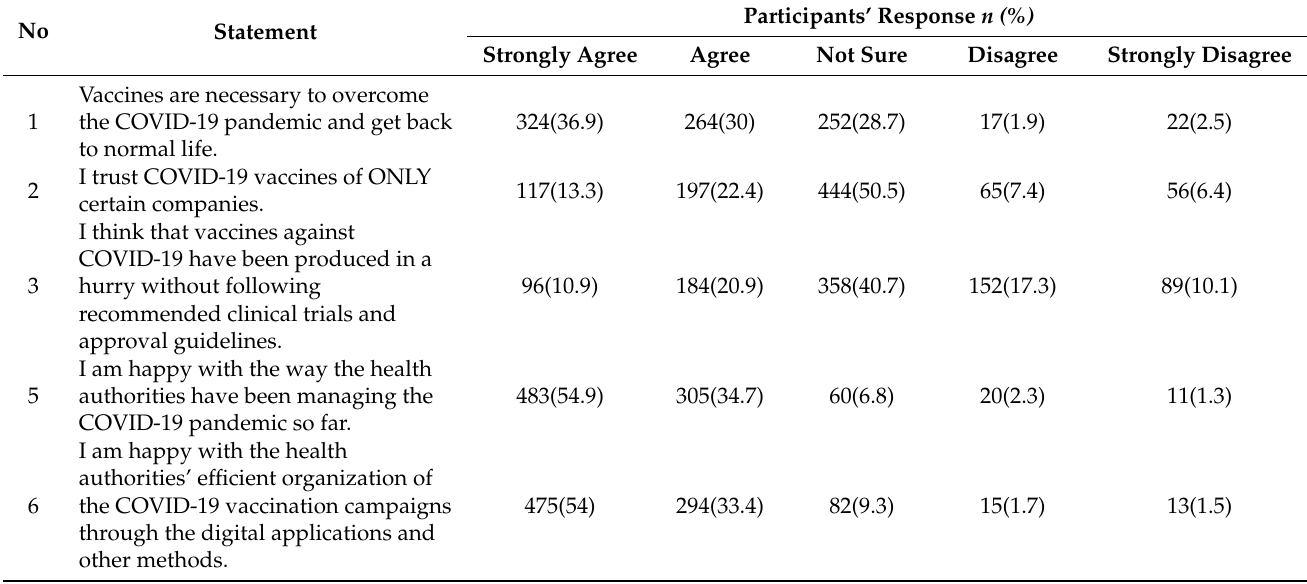
Table 3. Trust in COVID-19 vaccines and health